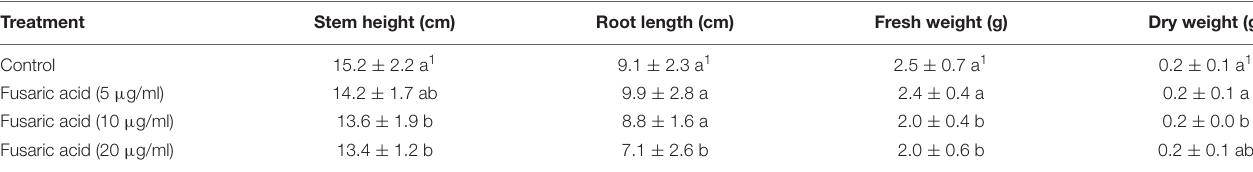
TABLE 6 | Effects of the different concentrations of fusaric acid on growth index of